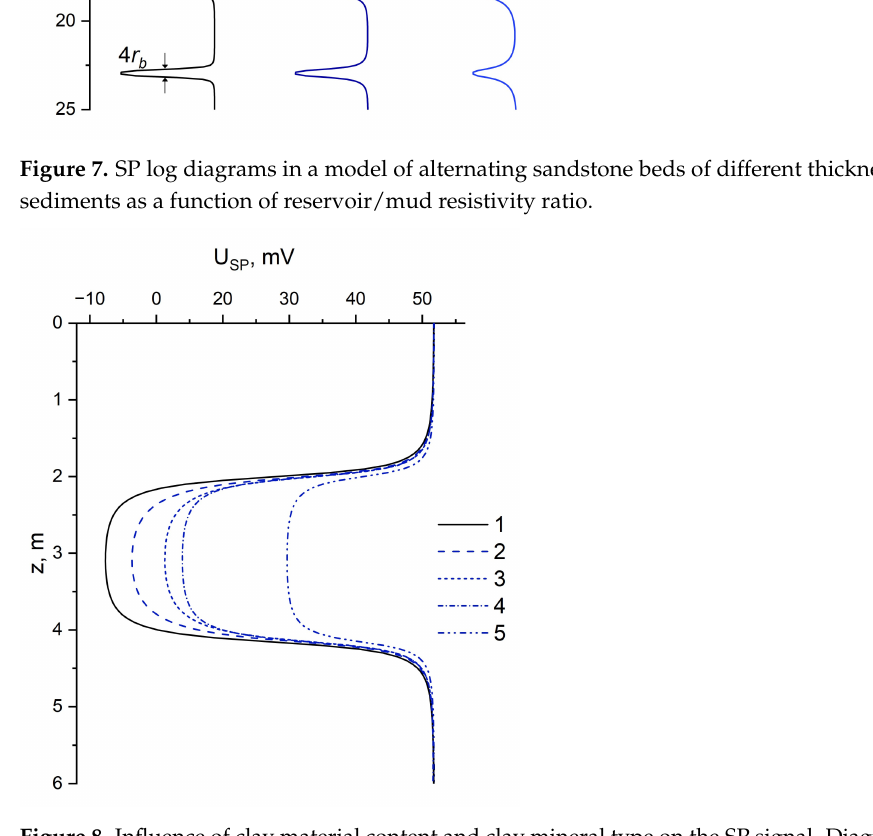
Figure 8. Influence of clay material content and clay mineral type on the SP signal. Diagrams number (porosity/content of clay material and type of clay mineral): 1–20/0%; 2–15/30% kaolinite; 3–15/30% illite; 4–18/10% smectite; 5–15/30%